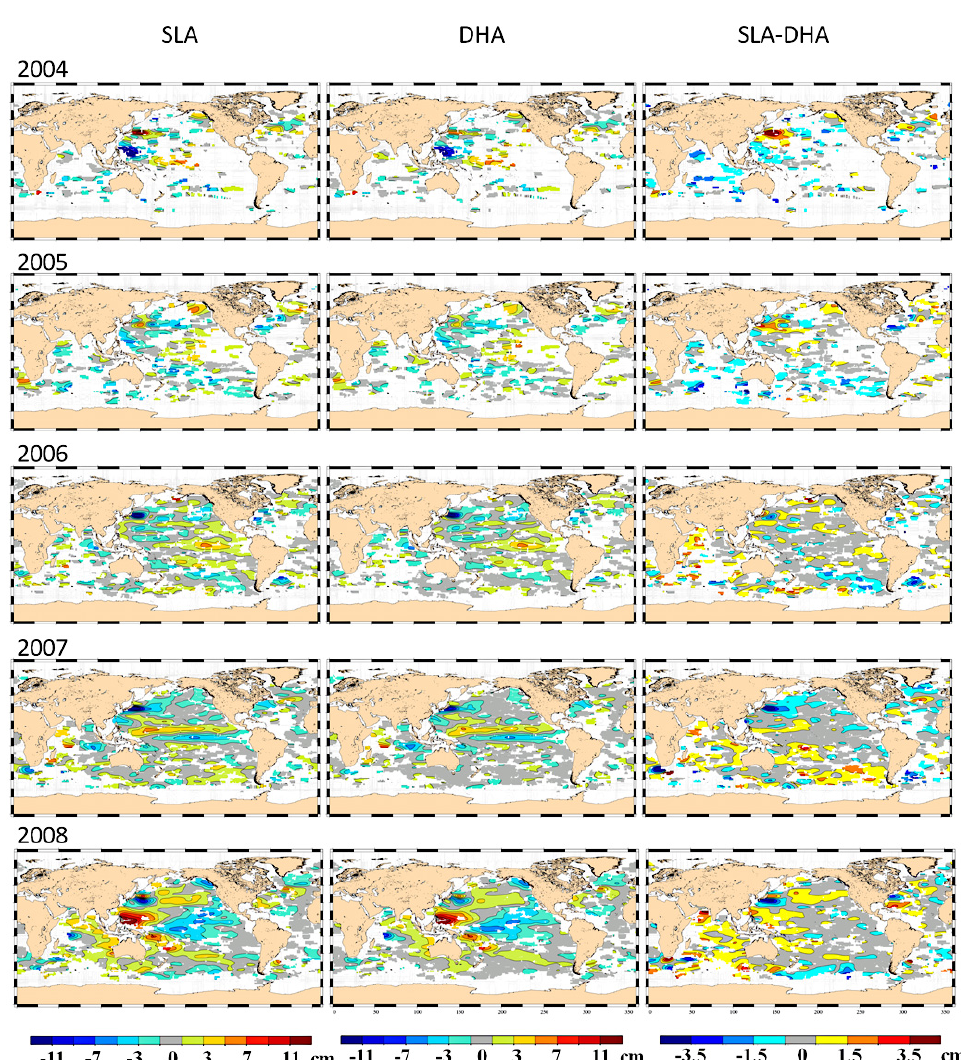
Fig. 8. Annual variations of SLA, DHA, and SLA-DHA for the years 2004 to 2008. Boxes with less than 20 observations (5 observations for each season, see text) are